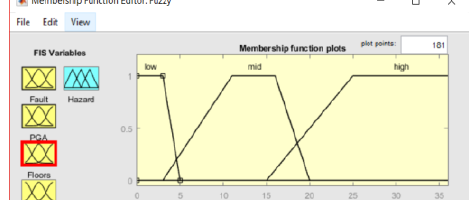
Figure 5. Structure types of the buildings